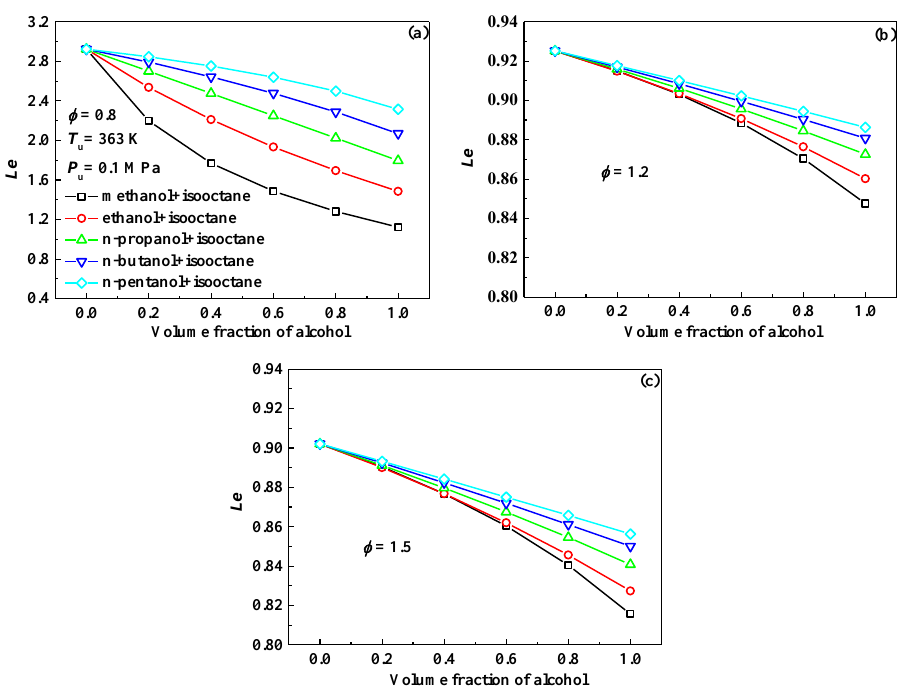
Figure 6. Lewis number of C1–C5 primary alcohol-isooctane blends at different equivalence ratios: ( a ) ϕ = 0.8; ( b ) ϕ = 1.0; and ( c ) ϕ = 1.2.